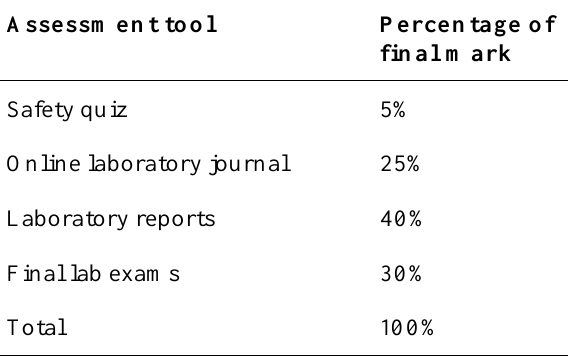
Assessment Tools and Valuations for the New Laboratory Courses Assessment